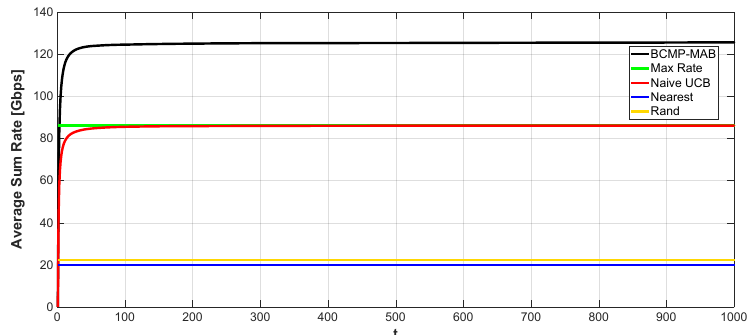
Figure 9. Average sum rate convergence against the time horizon using M = 100, and N = 20.